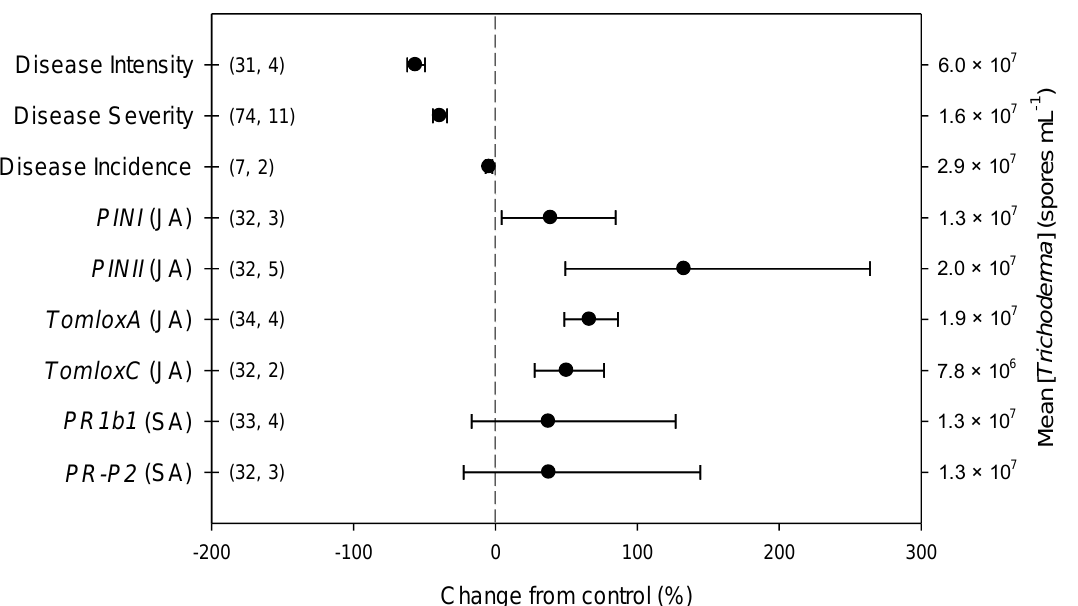
Figure 1. Effects of Trichoderma against Botrytis cinerea infection (i.e., disease intensity, severity and incidence) and defense-related genes involved in jasmonic (JA; i.e., proteinase inhibitors I and II, PINI and PINII , and tomato lipoxygenase A and C, TomloxA and TomloxC ) and salicylic acid (SA; pathogenesis-related 1b1 and P2, PR1b1 and PR-P2 ) pathways in tomato leaves. Symbols represent the mean percentage change due to Trichoderma treatment relative to control (i.e., B. cinerea infection without Trichoderma treatment), and the bars show the 95% confidence interval. Number of observations and papers are shown in parentheses; mean Trichoderma spp. concentrations are given along the right y axis.